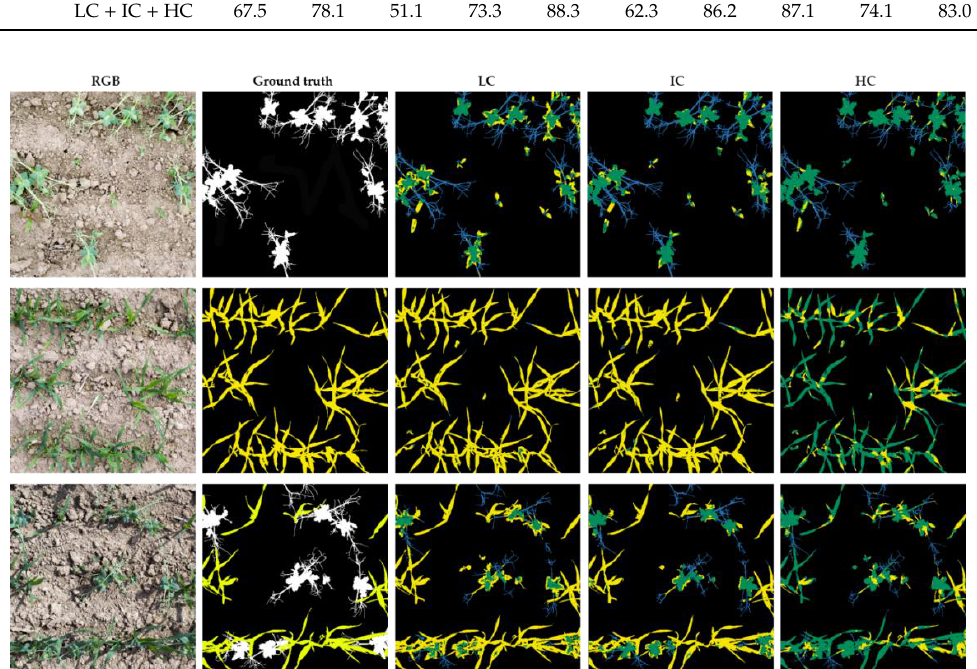
Figure 4. Examples for images from the intermediate cover dataset analyzed by the three individually trained networks. From top to bottom: pea, oat, and pea – oat intercrops (yellow: oat, green: pea, blue: pea tendrils, white: pea combined).